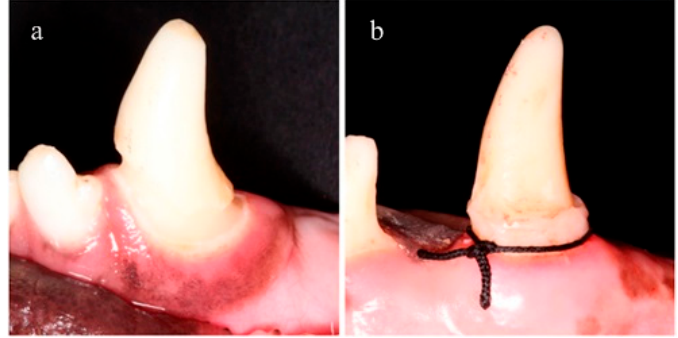
Figure 1. ( a ) Class V dental preparation of Beagle dogs canines; ( b ) Traditional ligature to induce